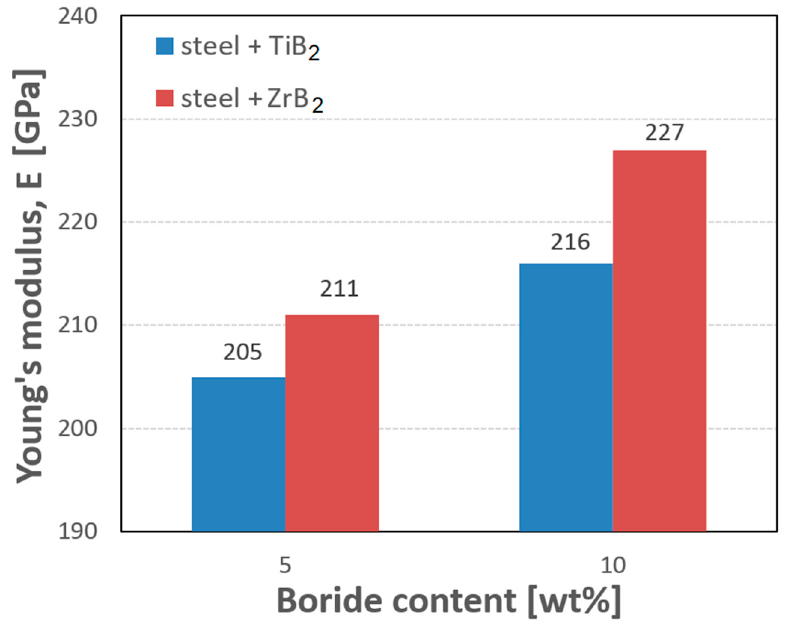
Figure 8. The results of the Young’s modulus measurements.